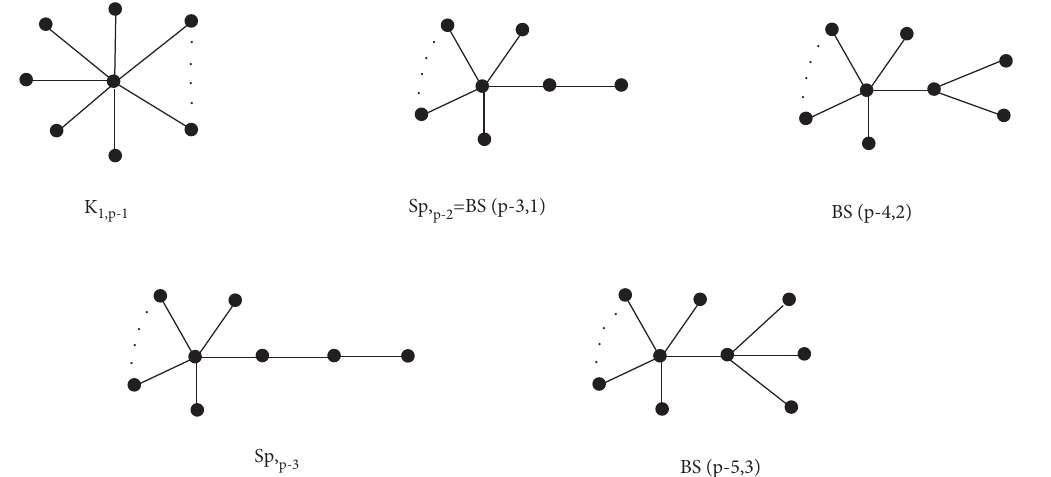
Figure 5: Acyclic connected graphs T having greatest M